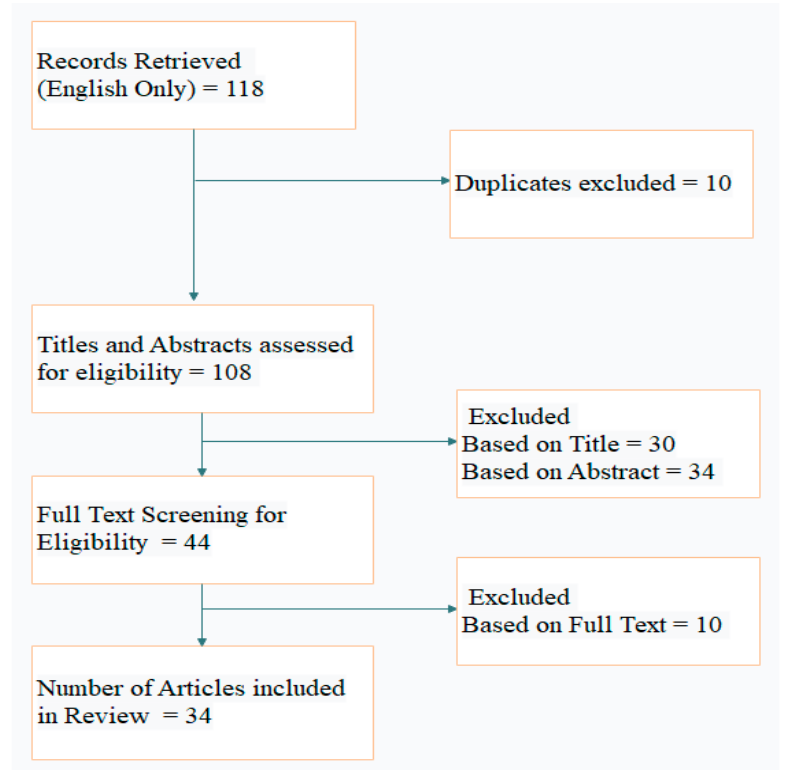
Figure 1. Flow diagram describing study selection.